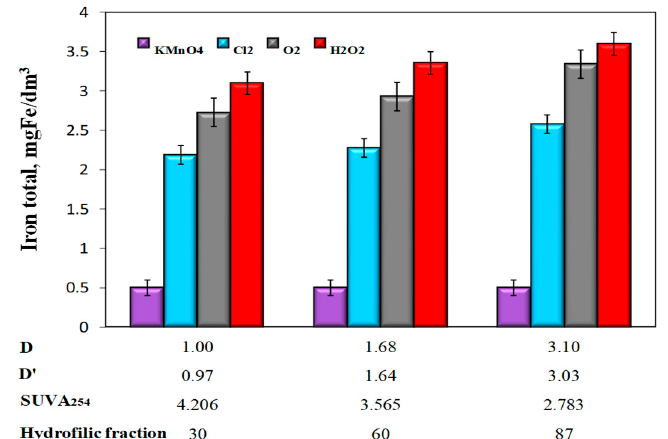
Figure 6. The influence of the type of oxidant and values of the co-occurrence coefficient of organic substances and total iron (D and D‘), SUVA 254 coefficient value, and the content of hydrophilic organic substances (%) on the concentration of total iron in water after sedimentation.